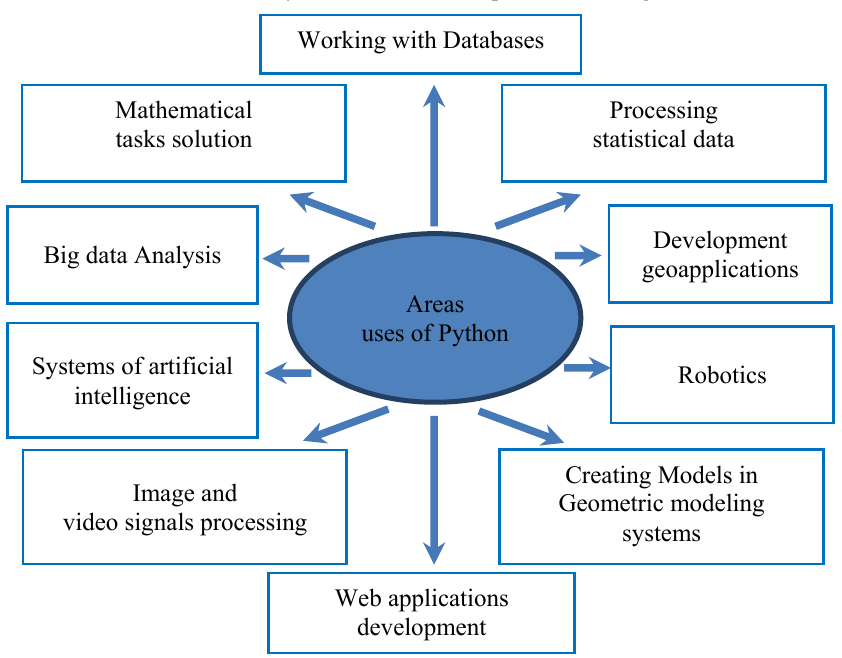
Fig. 1. Examples of Python usage